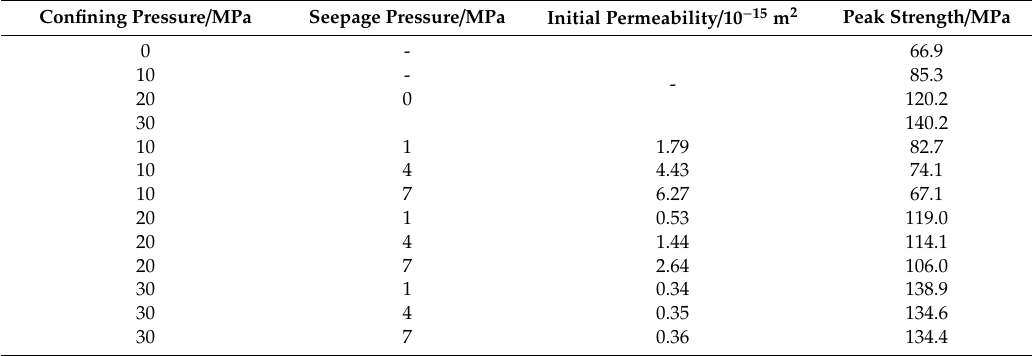
Table 1. Initial permeabilities and strengths of sandstone under different confining, and seepage, pressures. Confining Pressure / MPa